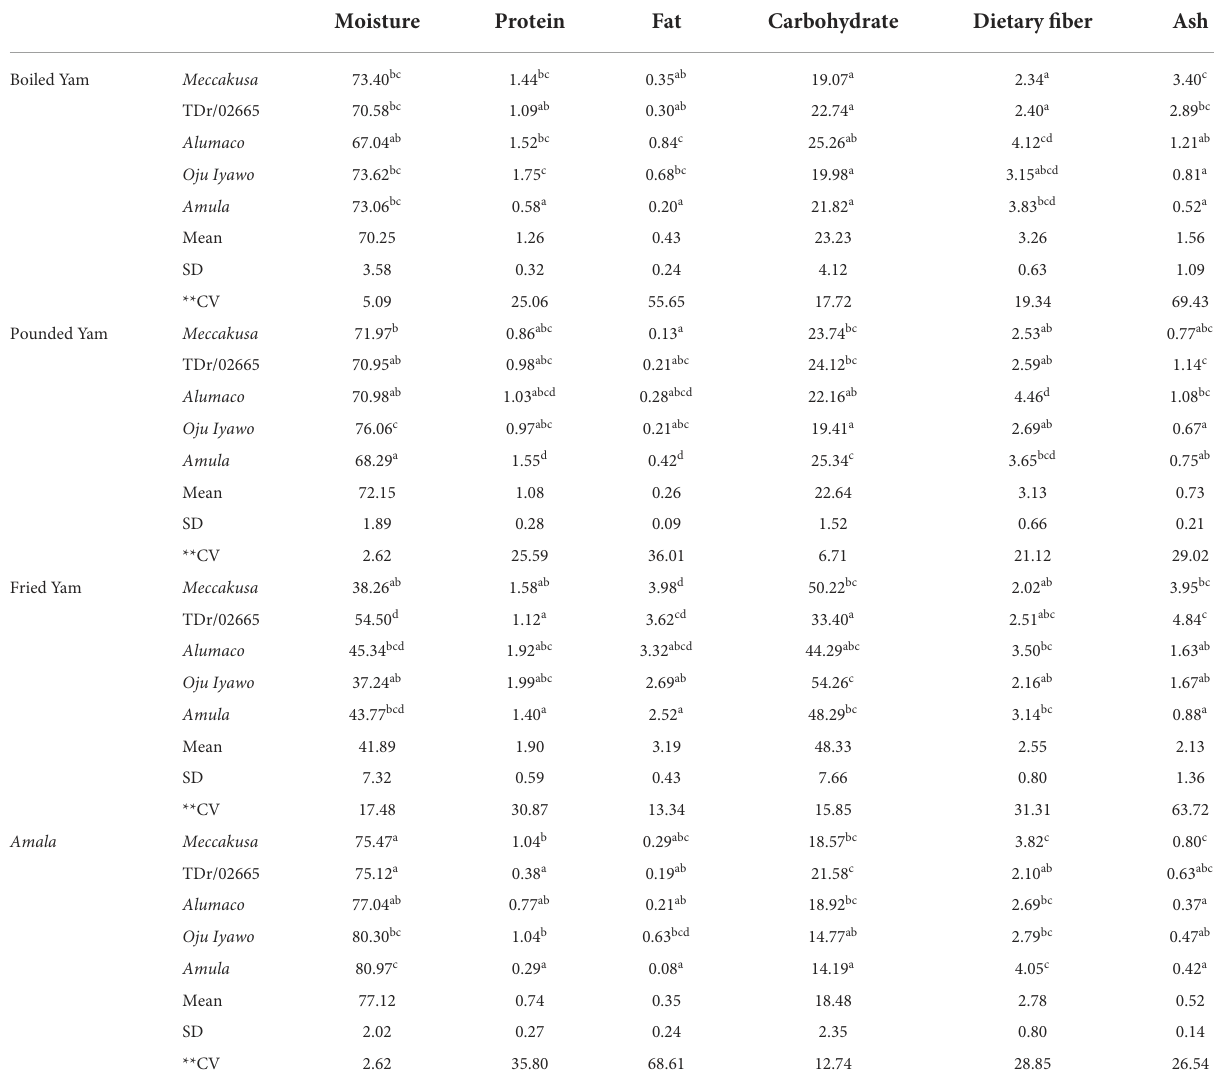
TABLE 1 Nutrient composition of products (per 100g) from varieties of Yam. Moisture Protein Fat Carbohydrate Dietary fiber